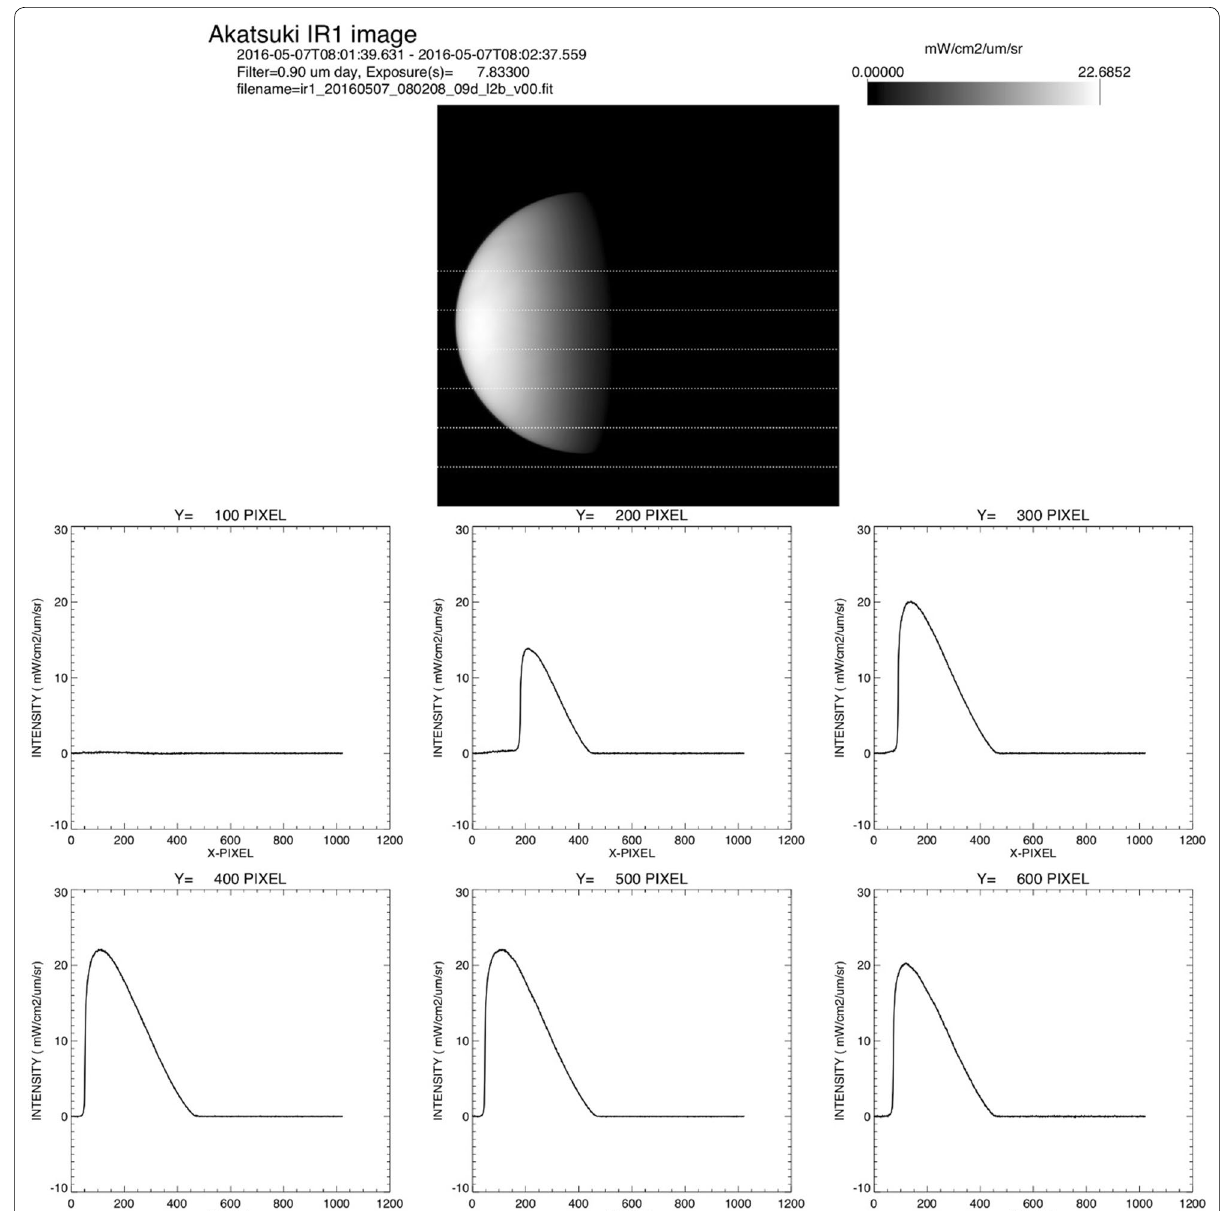
Fig. 8 Horizontal cross section of the Level 2 image after correction shown in Fig. 4b. The six panels on the bottom show intensity along the hori‑ zontal dotted line (at y 100–600) in the top image. The date and time are found in the top =